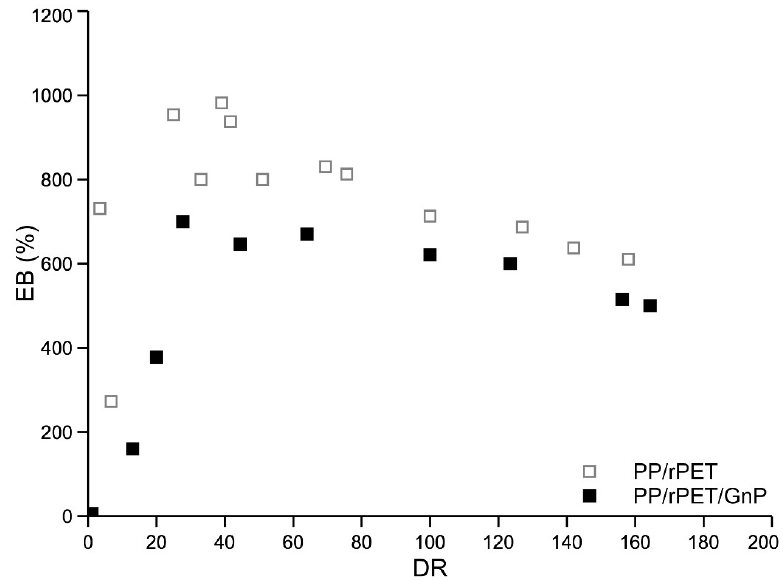
Figure 10. Elongation at break as a function of the draw ratio.